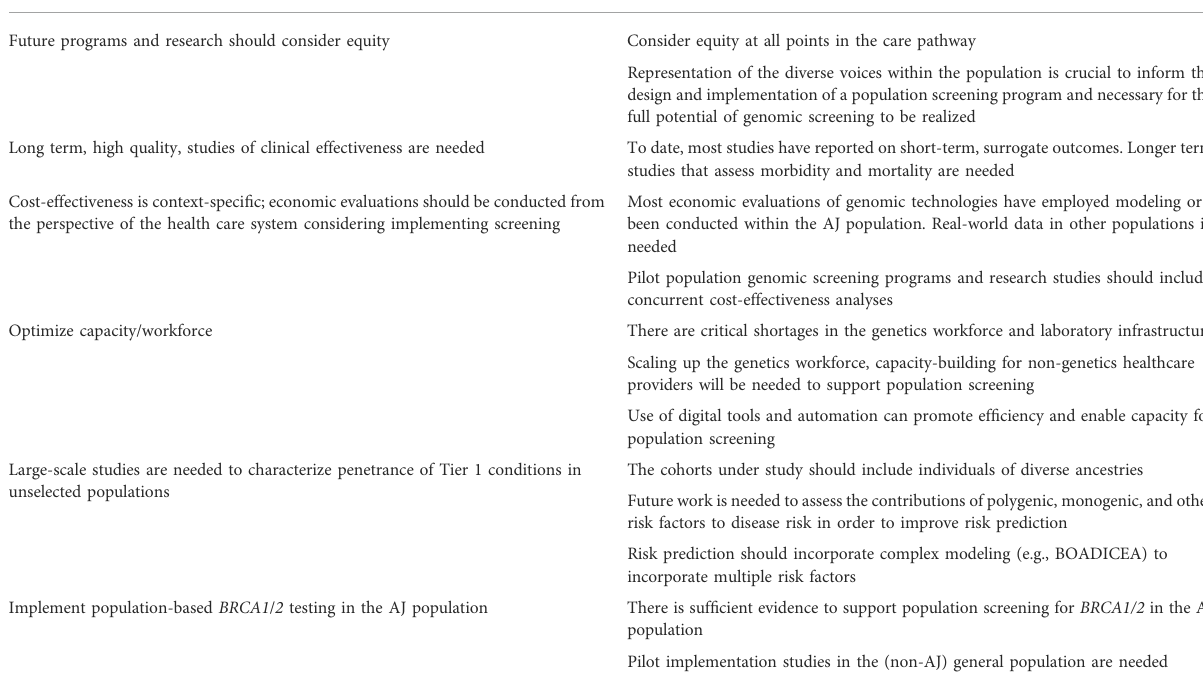
TABLE 3 Recommendations and future